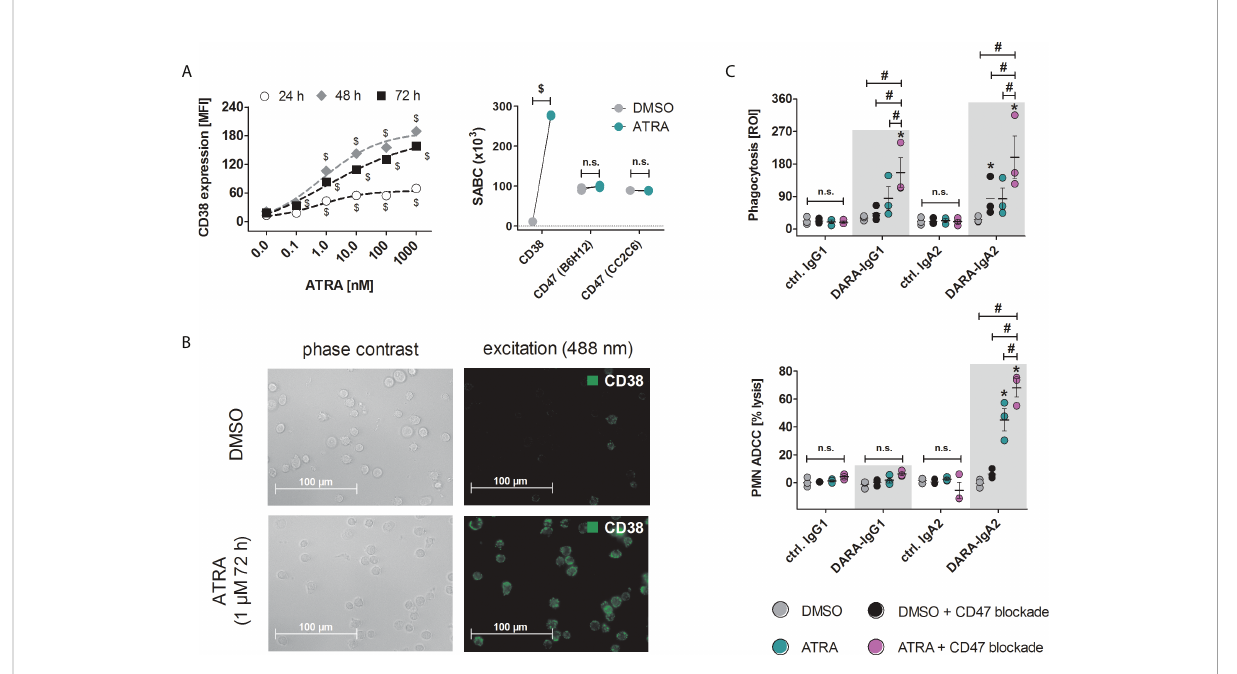
FIGURE 4 Treatment of HSB-2 cells with all- trans retinoic acid (ATRA) enhances CD38 expression and DARA-IgA2 mediated tumor cell killing by myeloid cells in combination with CD47 blockade. (A) Concentration and time dependent increase of CD38 expression on T-ALL cell line HSB-2 after treatment with ATRA at indicated concentrations for 24 h, 48 h and 72 h (left panel). CD38, CD47 expression and determination of the speci fi c antigen-binding sites per cell (SABC, right panel) after treatment with 1 µM ATRA for 72 h were quanti fi ed using QIFIKIT. For both CD38 stainings, antibody HB-7 at saturating concentration (5 µg/ml) was used, while for CD47 staining, both B6H12 and CC2C6 antibodies were used. FITC-conjugated goat anti-mouse IgG F(ab ’ ) 2 fragments as secondary reagent was used. Values of three independent experiments are shown. $ depicts signi fi cant differences between ATRA and DMSO control (p < 0.05 by two-way ANOVA in both panels). (B) Microscopic images of HSB-2 cells stained for CD38 with antibody HB-7 and FITC-conjugated goat anti-mouse IgG F(ab ’ ) 2 fragments (40x magni fi cation). (C) HSB-2 cells were treated with 1 µM ATRA or DMSO for 72 h and were then used in ADCP (upper panel) or PMN-mediated ADCC (lower panel) experiments. Daratumumab variants and ctrl. antibodies were applied at 10 µg/ml while CD47 blockade antibody 5F9-IgG2 s was used at 20 µg/ml. Values of three (ADCP and ADCC) different donors are depicted. * indicates signi fi cant differences between DARA and the respective isotype control (p < 0.05 by two-way ANOVA), # indicates signi fi cant differences between ATRA + CD47 blockade versus ATRA alone or CD47 blockade alone (p < 0.05 by two-way ANOVA). n. s., not signi fi